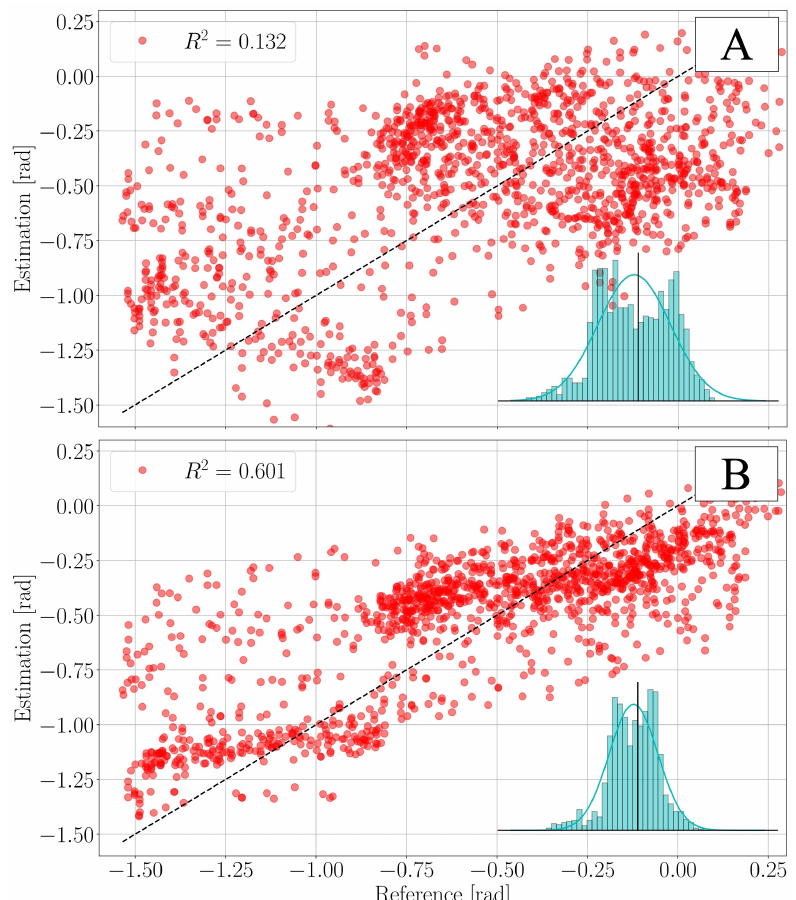
Figure 9. Visualization of the improvements brought by the KF for the pedal angle estimate ˆ θ . The plots above show how the pedal angle estimate ˆ θ compares to the reference values θ extracted from the video. The histograms show the error e = θ − ˆ θ distributions, the vertical line is located at e = 0 ◦ , and the bell curves are the Gaussian distributions N ( µ ( e ) , σ ( e )) , with µ ( e ) and σ ( e ) being the average error and the error standard deviation respectively. R 2 is the coefficient of